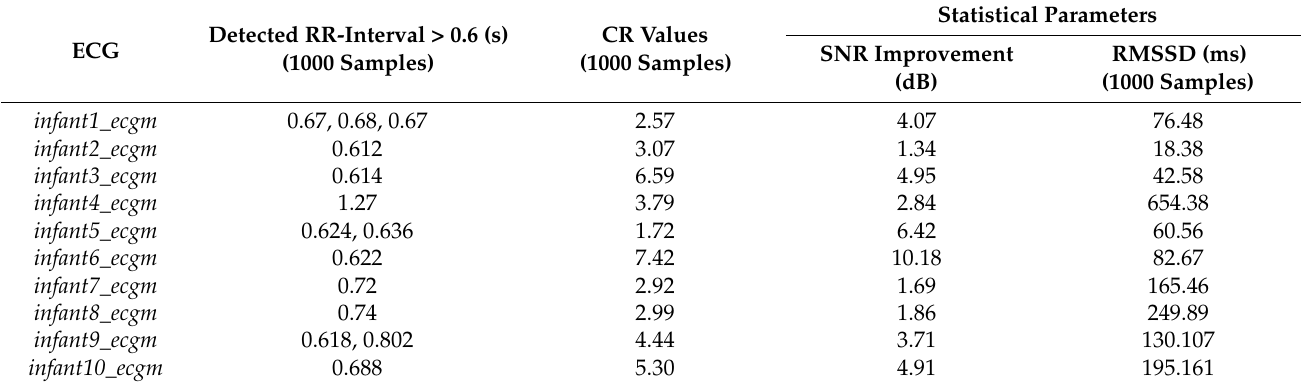
Table 1. Performance of RR peak detection wavelet algorithm for the preterm infants ECGs.